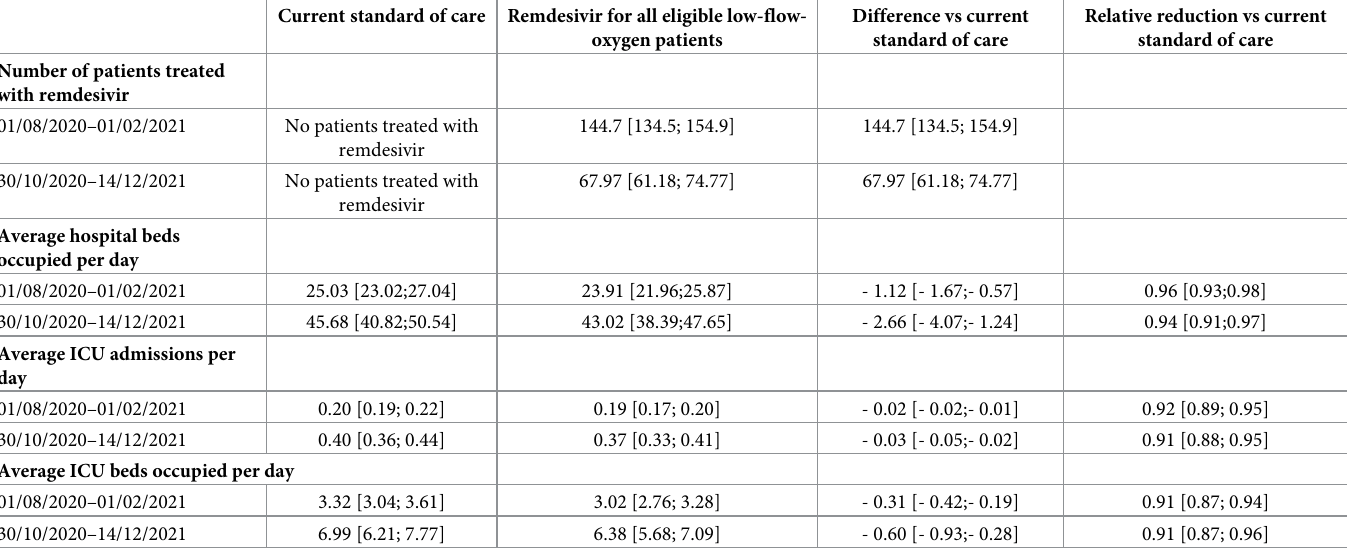
Table 1. Comparison of the number of patients treated with remdesivir, number of hospital bed-days occupied, number of ICU admissions and number of ICU bed-days occupied between 01/08/2020 and 01/02/2021 if remdesivir had been used for all eligible patients with low-flow-oxygen therapy since 01/08/2020. Ninety- five percent confidence intervals are estimated from 200 bootstrap simulations. Current standard of care Remdesivir for all eligible low-flow- oxygen